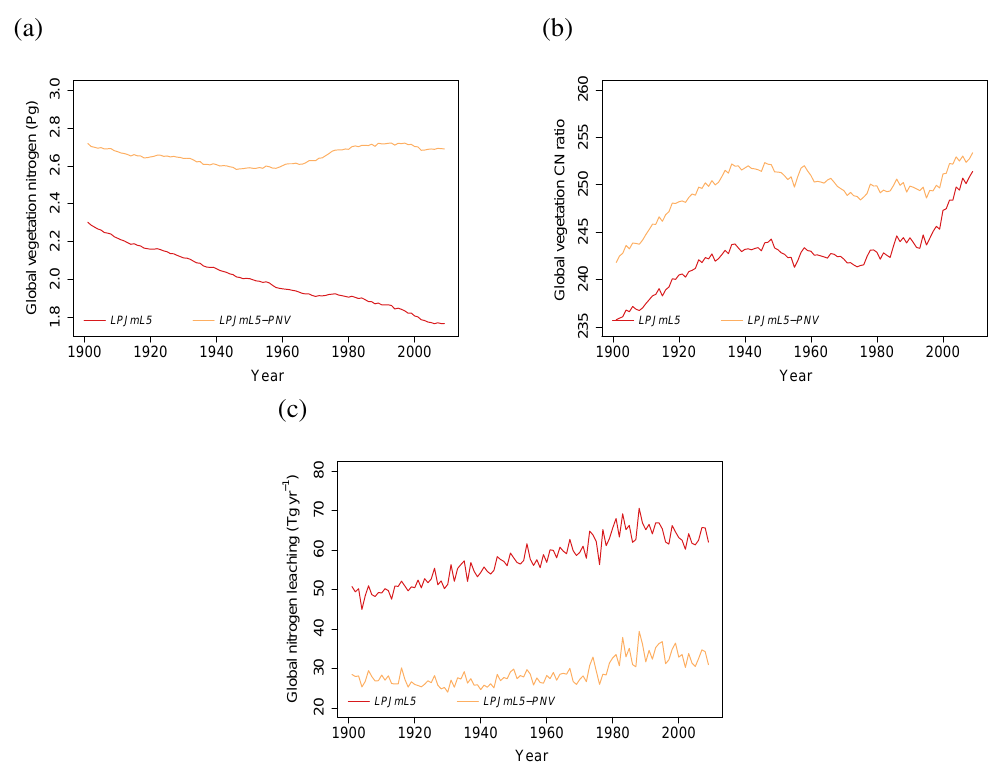
Figure 6. Simulated global time series of vegetation nitrogen (a) , vegetation C:N ratios (b) , and leaching (c) with land use ( LPJmL5 , red line) and potential natural vegetation ( LPJmL5-PNV , orange line).